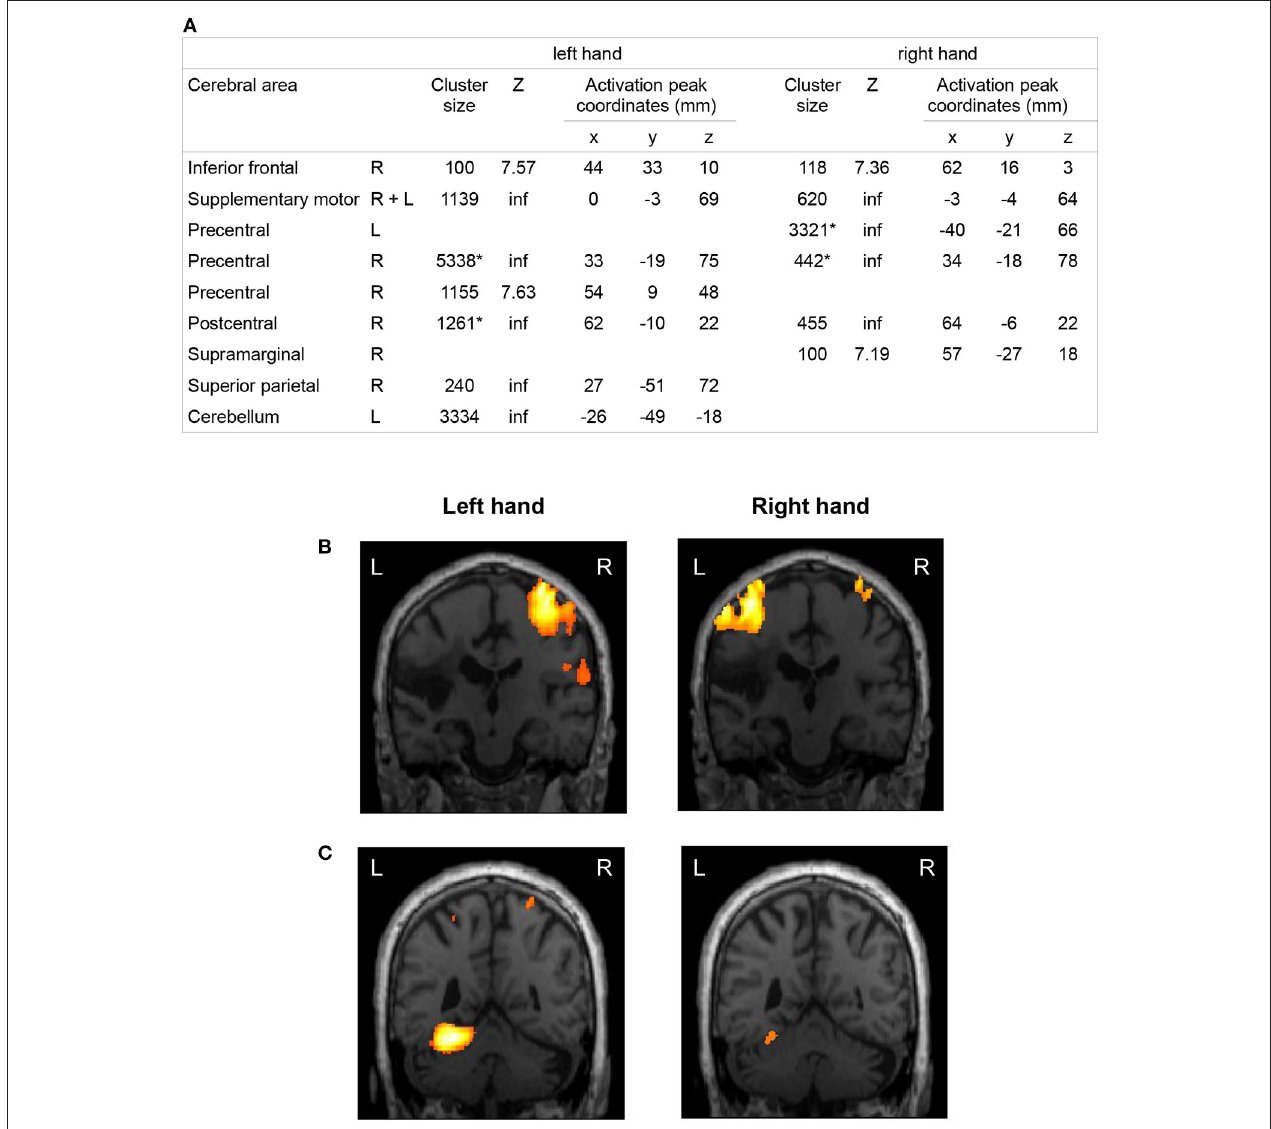
FIGURE 3 | fMRI activations during a finger opposition movement in the patient 12 years after stroke. Brain areas activated by the movement of the left unaffected hand and the right affected hand of the patient compared to rest. The coordinates of the local maximum and the Z score were displayed for each significantly activated cluster of more than 100 voxels ( p < 0.001, FWE corrected). The origin of the coordinates is at the anterior commissure in the Talairach space. R, right; L, left; inf, infinite. *Clusters including both pre- and post-central gyri (A) . Activation maps were represented in the coronal plane corresponding to the activation peak of the cluster ( p < 0.001, FWE corrected at the voxel level) of the contralateral primary motor cortex (B) and the cerebellum (C) during the left and right hand exercise (L, left; R,